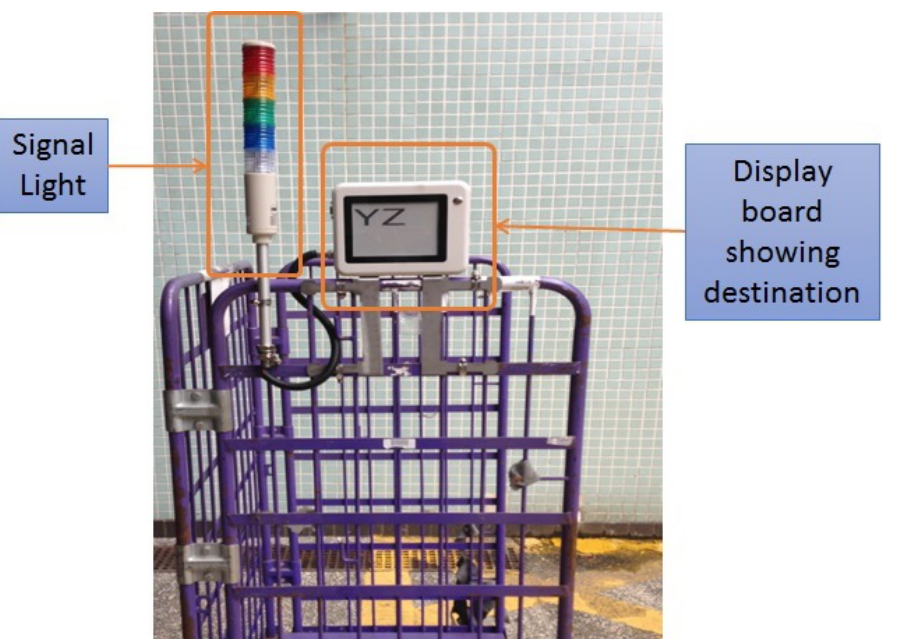
Figure 5. A tagged cart (with a display board showing the destination of the mail bags and a signal light) for circulating mail bags within the facility.